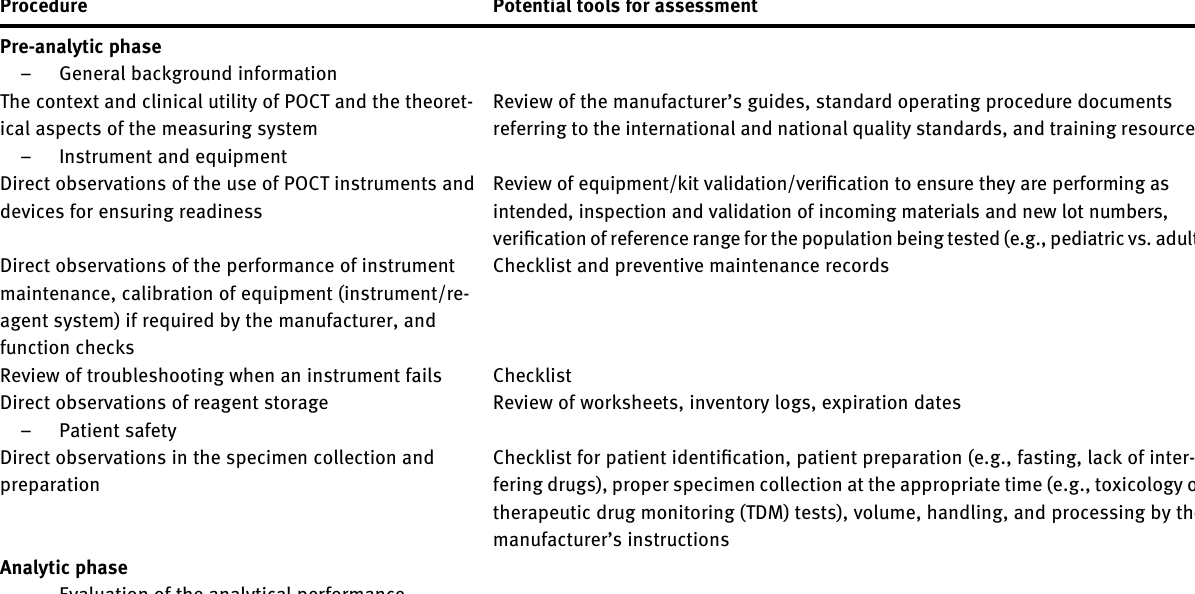
Table  : A training and education program for staff shall include the following learning on assessment procedures and tools, as